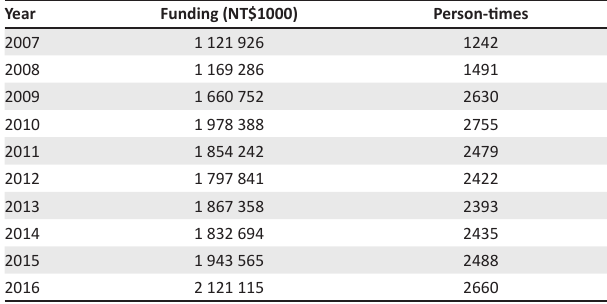
TABLE 2: Recruitment of science and technology personnel,